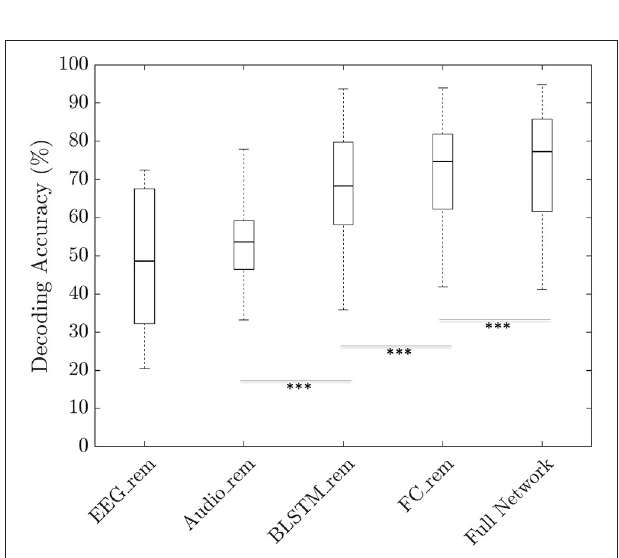
overlap was used and for 3 s trial, 2 s of overlap was used, and